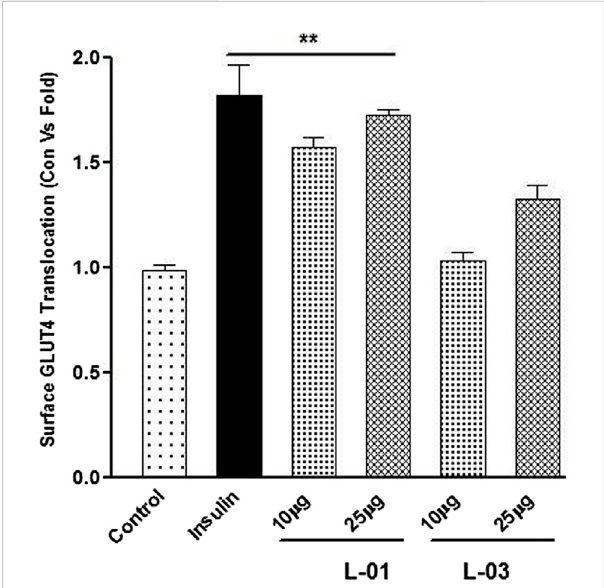
FIGURE 7 Dose-dependent effect of extract (L-01) and ethyl acetate fraction (L-03) on stimulation of GLUT4 translocation in L6 GLUT4 myc myotubes. Cells were incubated with either L-01 or bioactive fraction L-03 at 10 and 25 μ g/mL concentration for 16 h, and rate of GLUT4 translocation was determined. Results shown are mean ± SE of the results of three independent experiments, each performed in triplicate. p * < 0.01, ** p < 0.05, p *** < 0.001 relative to control.